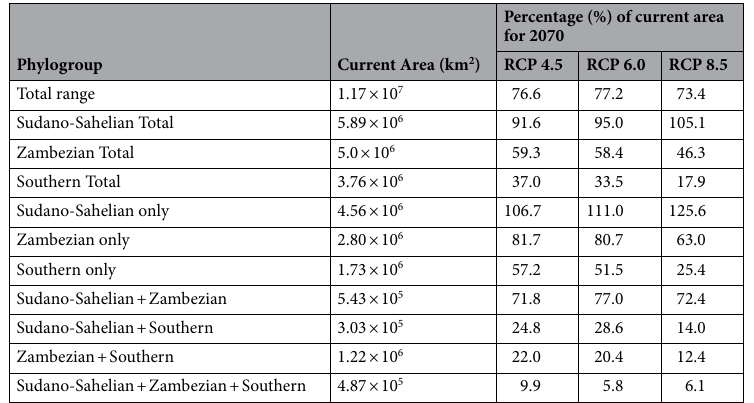
Table 3. Current suitable area and predicted area (as percentage of current area) for each phylogroups of Senegalia senegal and their co-occurrence for the three climate change scenarios RCP 4.5, RCP 6.0 and RCP 8.5 for the year 2070. Predicted area percentage > 100% and < 100% indicates gain and loss of area,